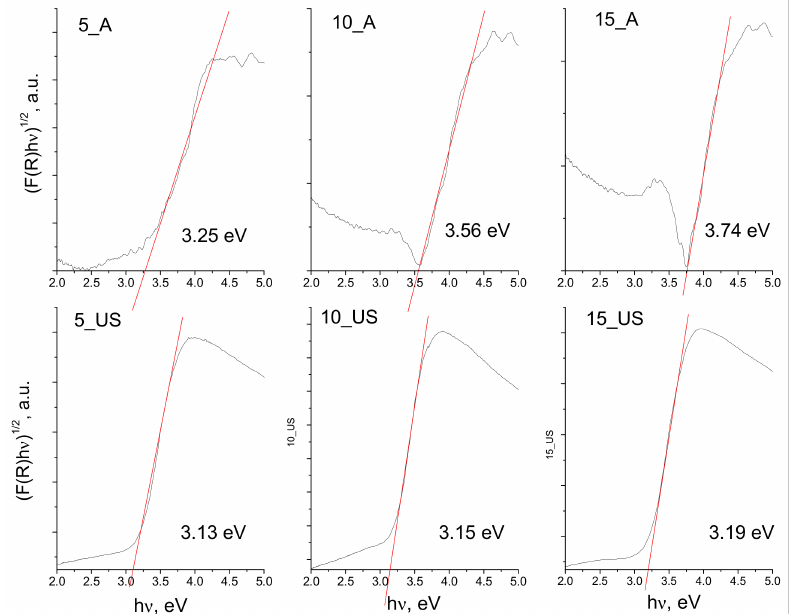
Figure 5. Tauc plots for synthesized titania samples (A-series and US-series) and corresponding band gap energies.